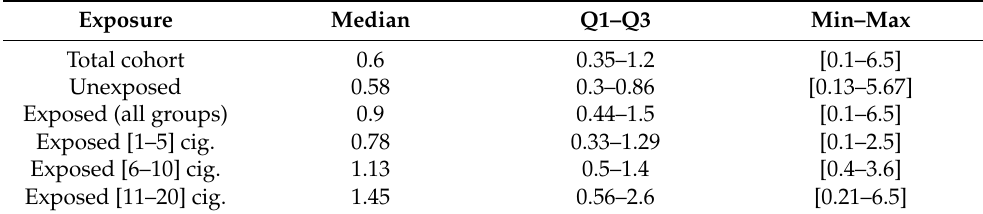
Table 3. Duration of the hospitalization/age (days/months) depending on prenatal exposure to